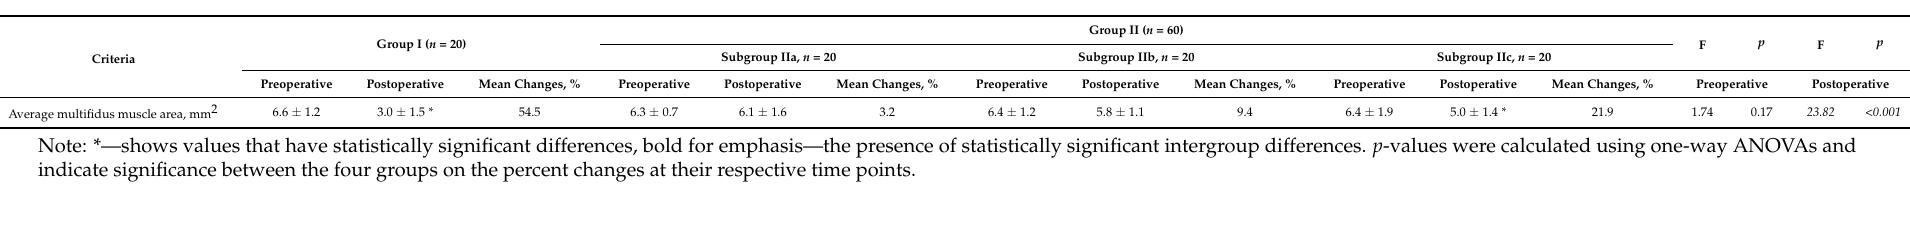
Table 6. Changes of the multifidus muscle of the studied group of